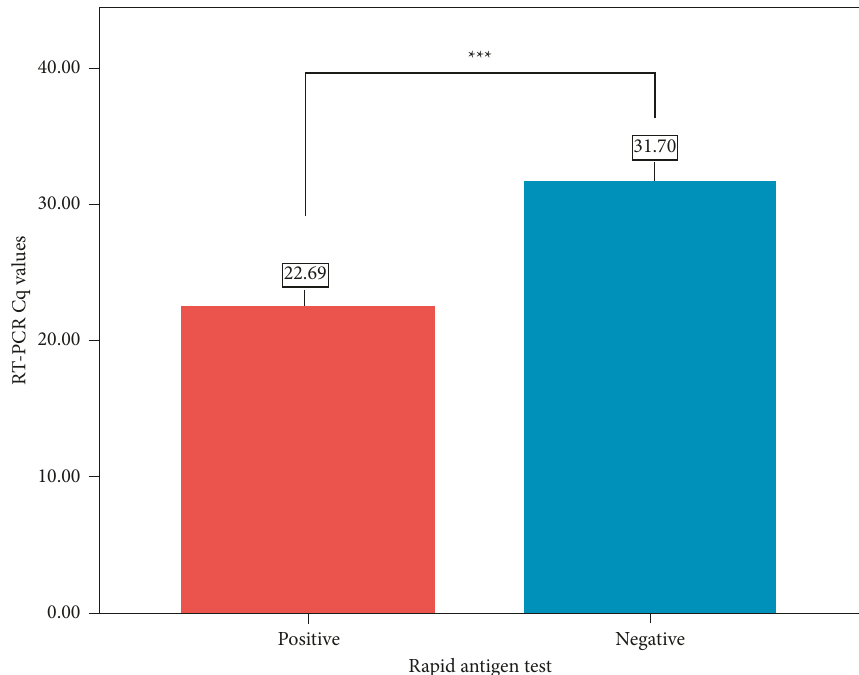
Figure 3: Positive and negative Ag-RDT test results in relation to RT-PCR C